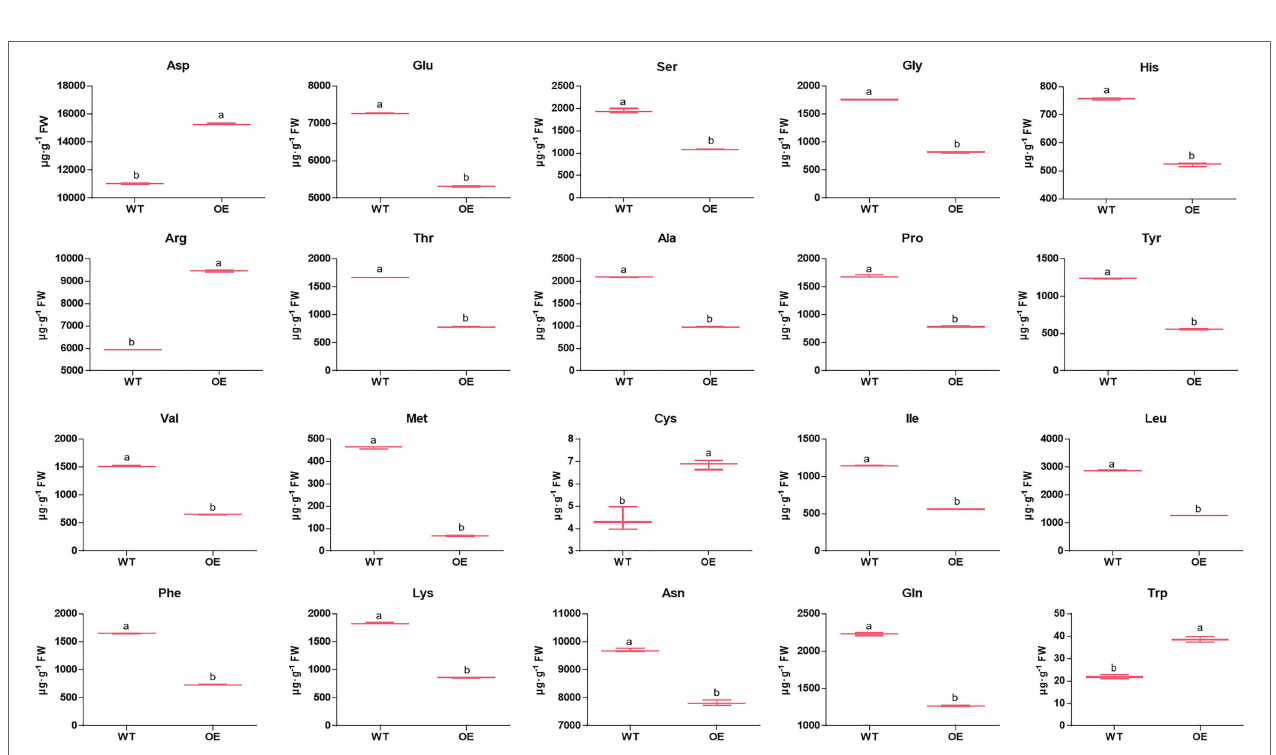
FIGURE 4 | PpEBB1 greatly influenced nitrogen metabolism. DEPs involved in nitrogen metabolism between PpEBB1-oe and WT. Proteins with significant ( p < 0.05) > 1.3 or <1/1.3-fold changes between PpEBB1-oe line 29 and WT were identified as DEPs. Purple represents higher expression, while blue represents lower expression. The expression value of DEPs in proteomics data were processed by Min-MaxNormalization from 0 to 1, and the scale is represented in the expression level.